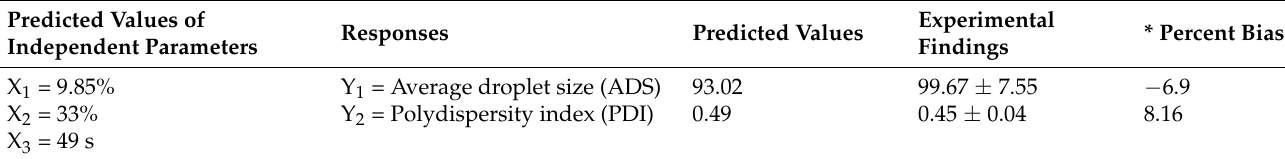
Table 6. Findings of the tadalafil nano ‐ emulsion optimization.